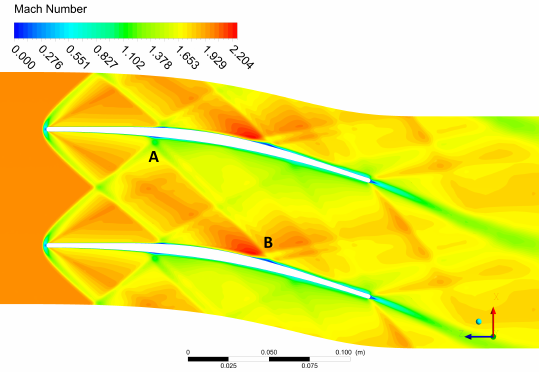
Figure 12. Mach number field for the stator in optimal loading